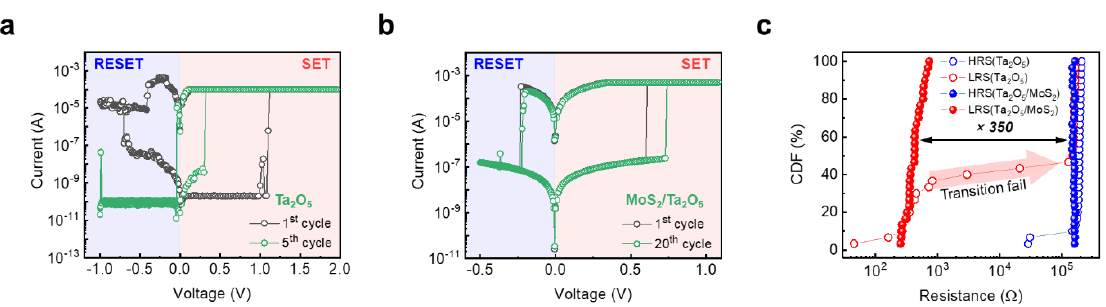
Figure 2. Direct current (DC) current – voltage (I – V) characteristics of Pt/Ta 2 O 5 /Ag device ( a ) and Pt/Ta 2 O 5 /MoS 2 /Ag device ( b ) where the switching cycle of set and reset are up to 5 times and 20 times, respectively. ( c ) Cumulative distributions function (CDF) of LRS and HRS on the Pt/Ta 2 O 5 /Ag device and Pt/Ta 2 O 5 /MoS 2 /Ag device. In the Pt/Ta 2 O 5 /Ag device, the LRS collapsed, but the Pt/Ta 2 O 5 /MoS 2 /Ag device has excellent uniformity, and the average on/off ratio is about 350.